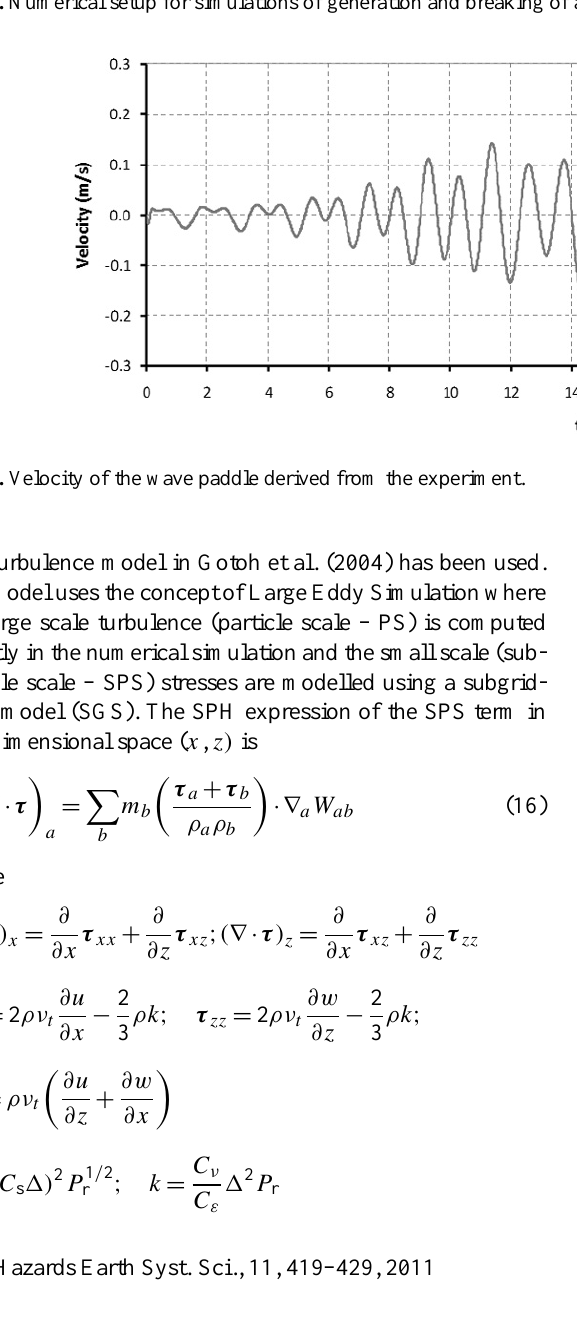
Fig. 2. Numerical setup for simulations of generation and breaking of an extreme wave.